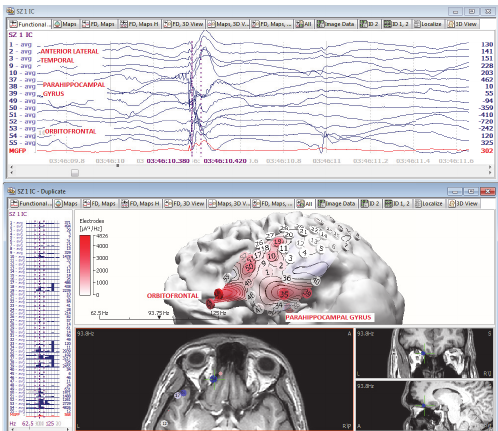
Figure 3: HFO mapping of initial ictal activity at the orbitofrontal and mesial temporal ictal activity of a typical seizure. The EEG data on top depicts the time window where the HFO power was calculated. The bottom image on the left side displays the graphic bar power on each EEG channel and the right side represents the localization onto a 3D model based on the patient’s own